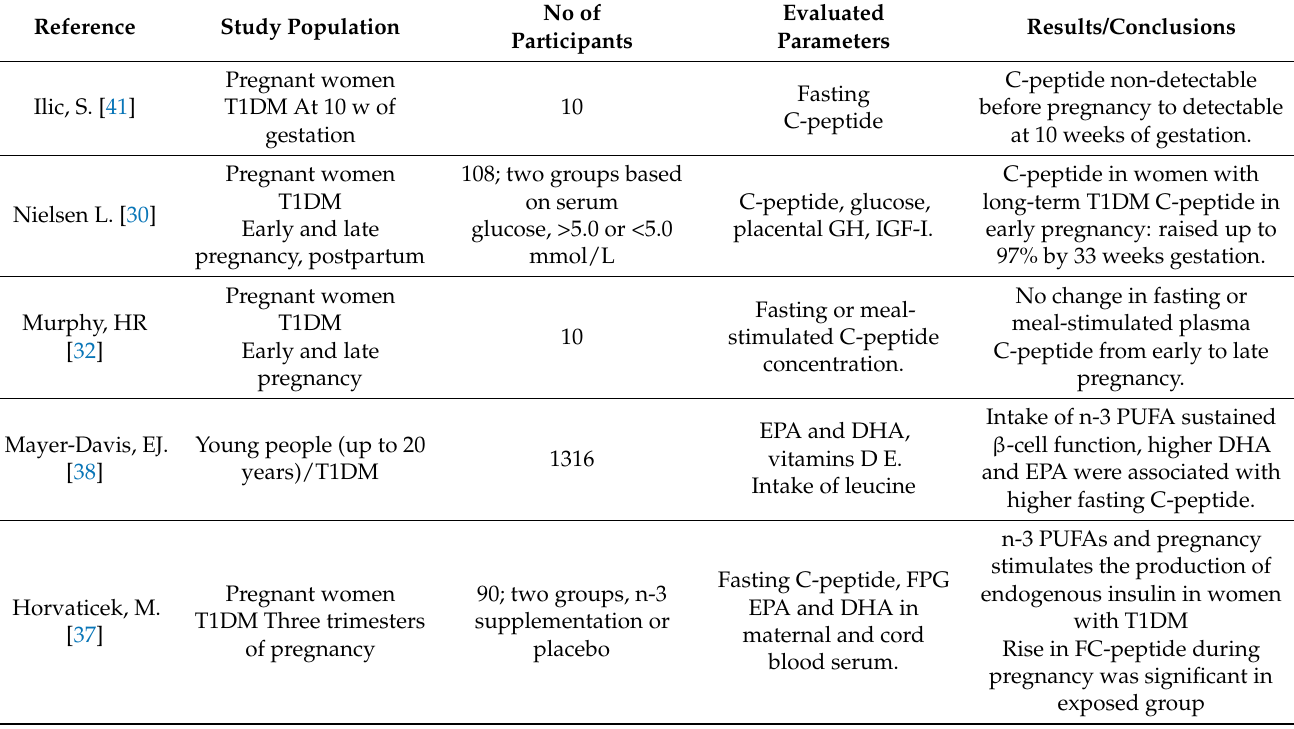
Table 1. Reviews of studies that evaluate C-peptide levels in pregnant women and young population with type 1